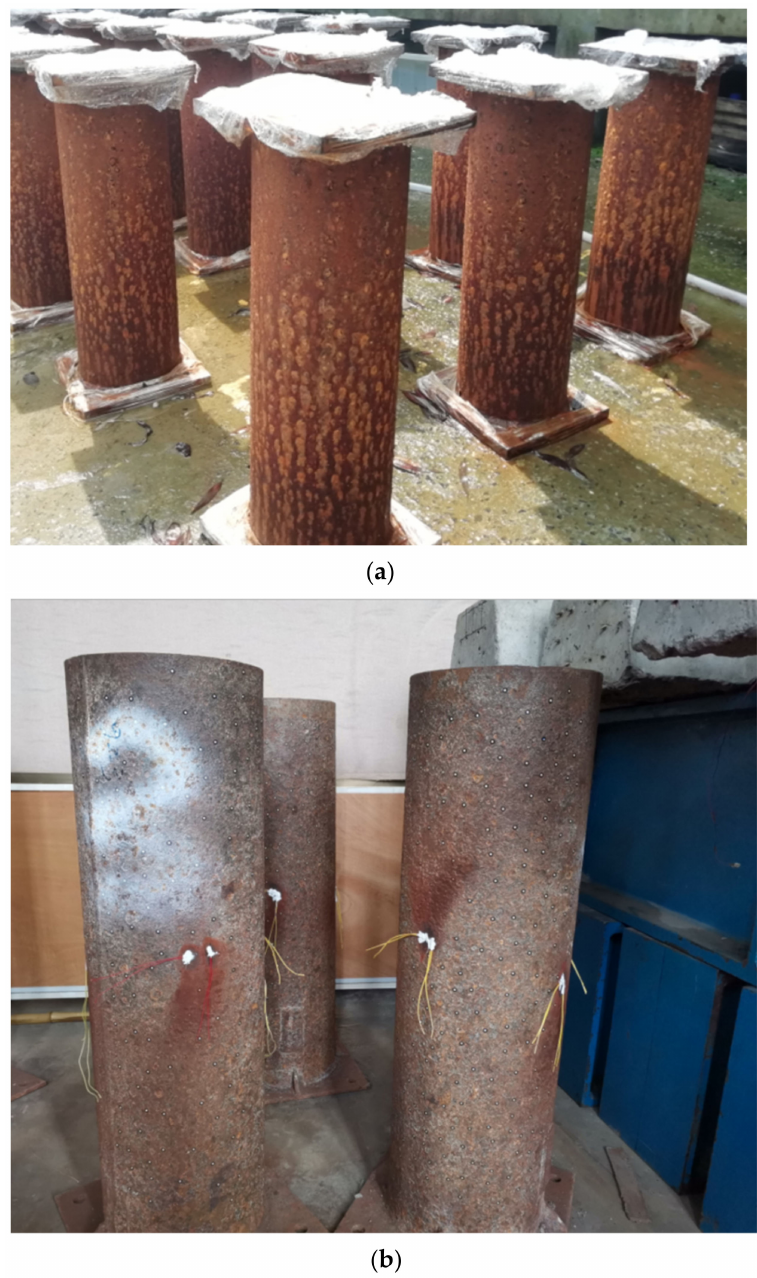
Figure 2. Corroded CFST specimens: ( a ) specimens corrosion accelerated by NaCl (CT series); ( b ) specimens corrosion in atmosphere (AT